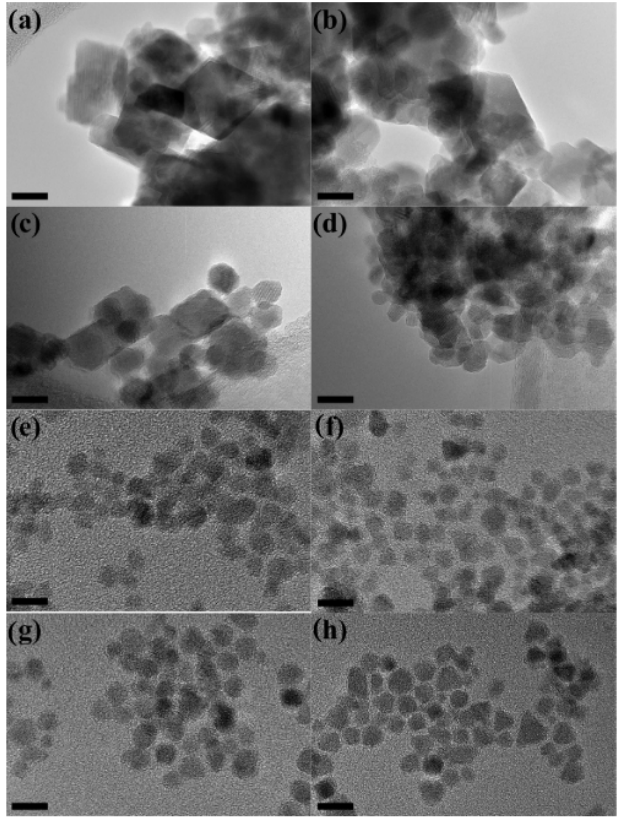
Figure 8. TEM images of cobalt ferrite NPs synthesized with ( a ) 0, ( b ) 0.1, ( c ) 0.15, ( d ) 0.2, ( e ) 0.25, ( f ) 0.5, ( g ) 1, and ( h ) 2 M of oleic acid. Scale bar is 10 nm. The figure is reproduced with permission from Jovanovic et al. [55].